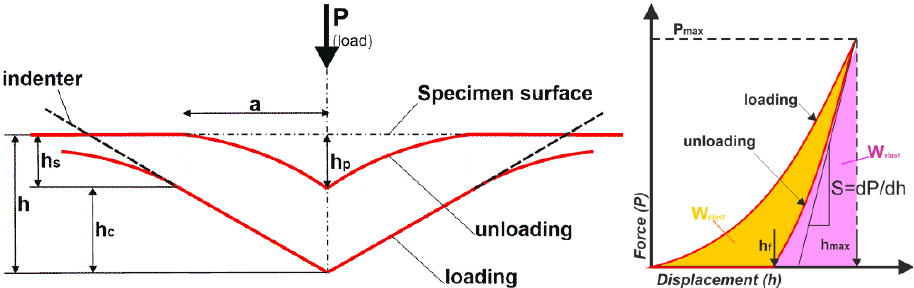
Figure 2. Schematic of the indenter contact with the test surface and theoretical force-displacement characteristics with important test parameters marked